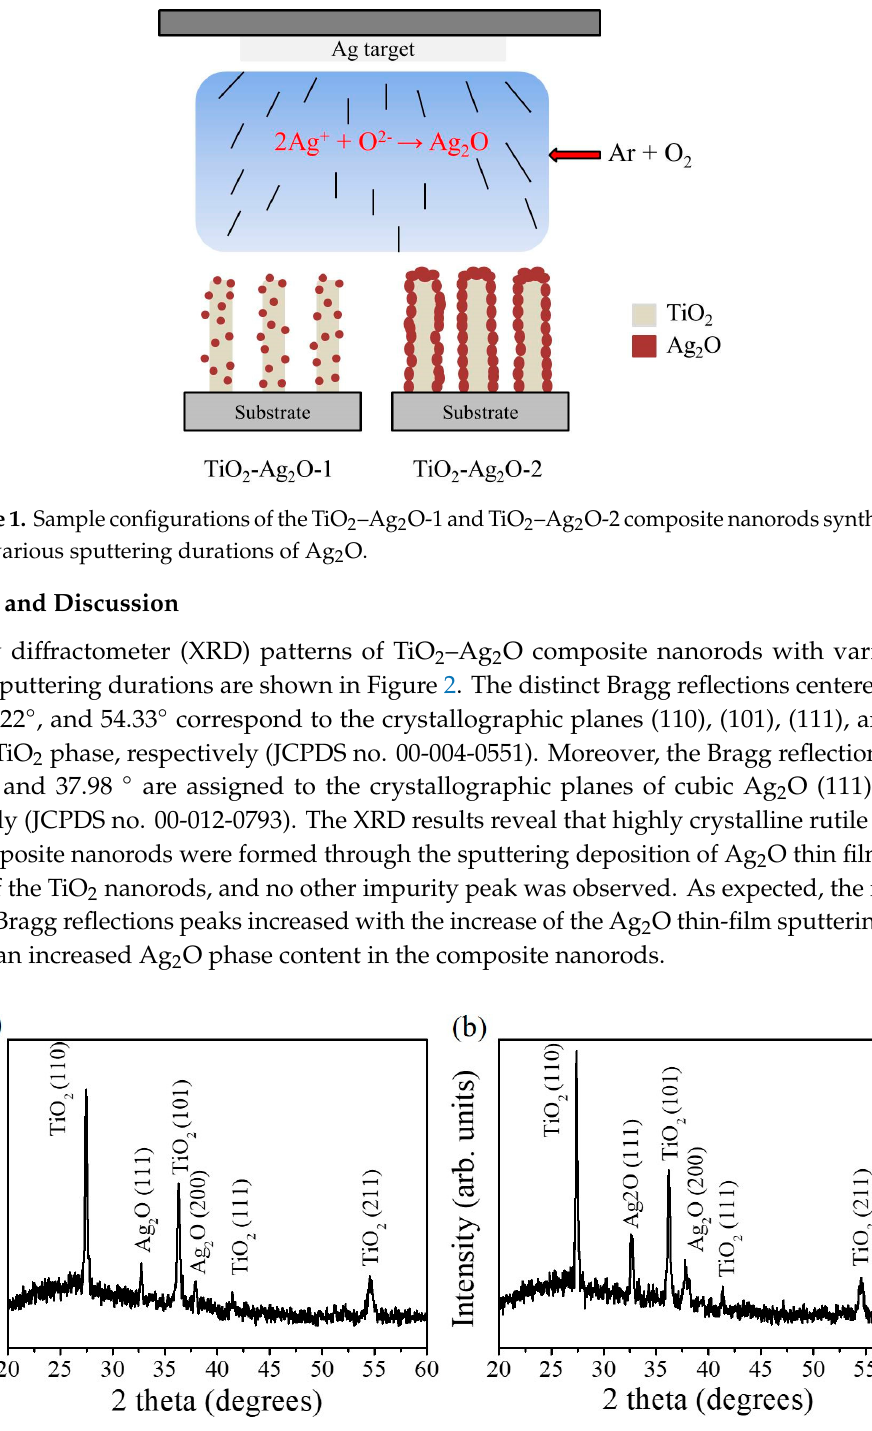
Figure 2. XRD patterns of various composite nanorods: ( a ) TiO 2 –Ag 2 O-1, ( b ) TiO 2 –Ag 2 O-2.